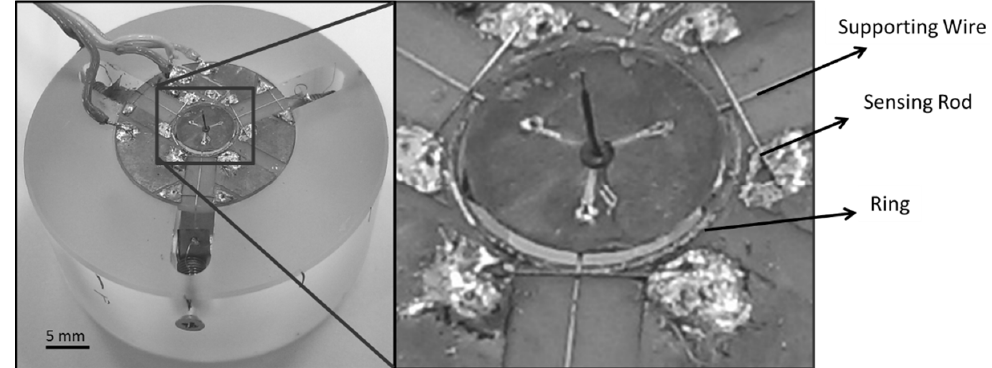
Figure 2. Tri ‐ switches tactile probing structure.